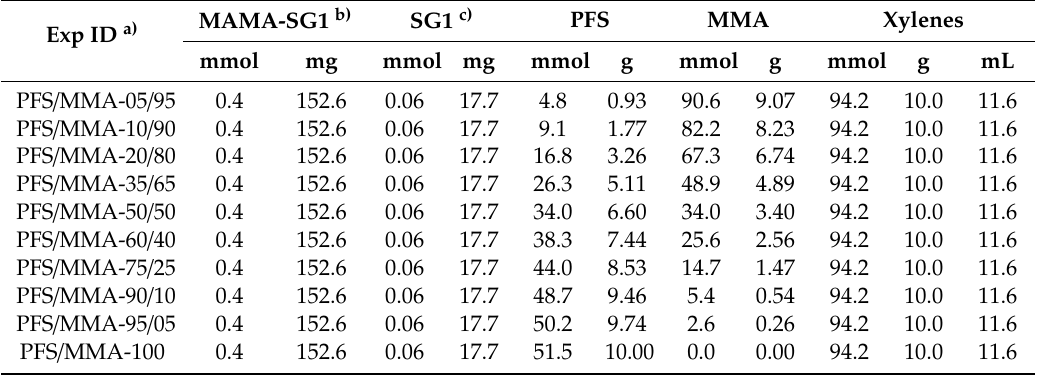
Figure 1. Chemical reaction scheme of 2,3,4,5,6-pentafluorostyrene / methyl methacrylate nitroxide mediated copolymerizations. Table 1. Formulations for 2,3,4,5,6-pentafluorostyrene / methyl methacrylate random copolymerizations in 50 wt% xylenes solution at 90 ◦ C initiated by